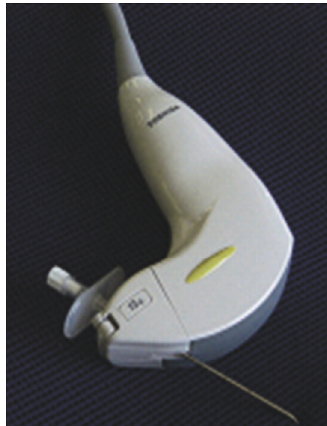
Figure 1: We participated in development of a dedicated ultrasonic transducer and have used it in 12,000 procedures of radiofrequency ablation. The dedicated ultrasonic transducer has the following advantages: (1) needle slot is located inside the transducer, (2) a puncture angle of 100 degrees is available in addition to 55, 70, and 85 degrees, (3) the same image is obtained as a regular convex transducer generates, (4) a puncture attachment is unified with the transducer, and (5) it is capable of multimodality fusion imaging.